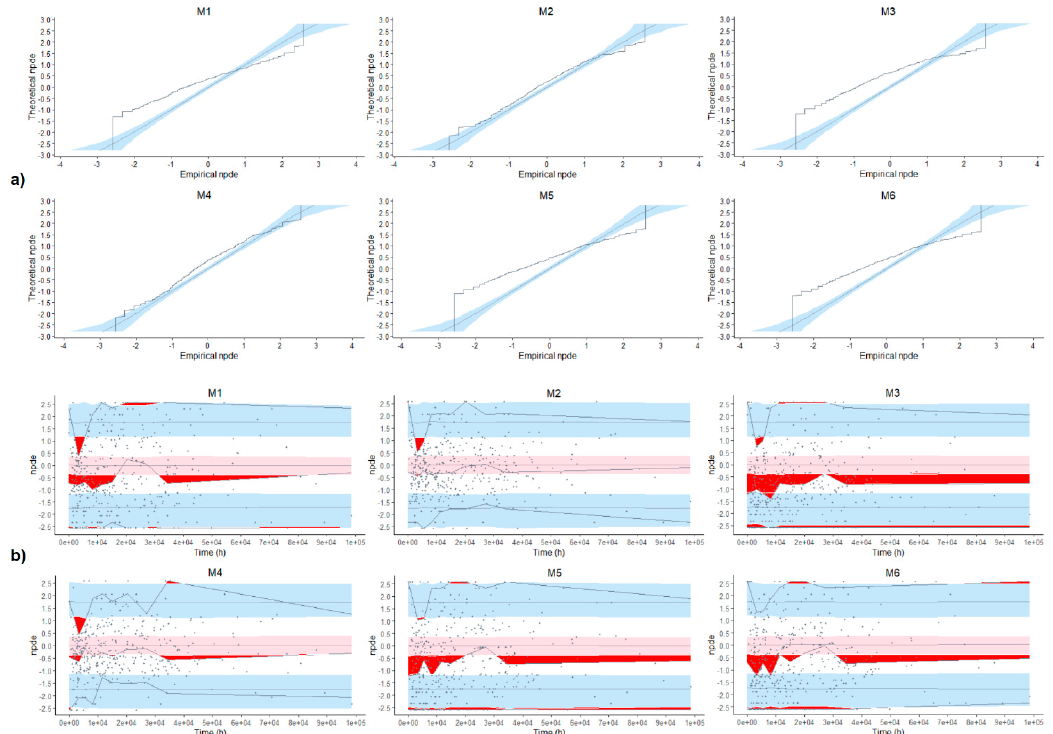
Figure 2. NPDE for each model. ( a ) Quantile-quantile plot of the npde versus the corresponding quantiles of a normal distribution. ( b ) Plot of npde versus time. Solid horizontal lines are the lines corresponding to 0, 5% and 95% critical values; gray solid lines, prediction intervals; blue-shaded area, 90% confidence interval (CI) of the 5% and 95% critical values; pink-shaded area, 90% CI of 0; red-shaded area, outliers of the bounds of the CI. The M numbers represent the models described in Table 1.